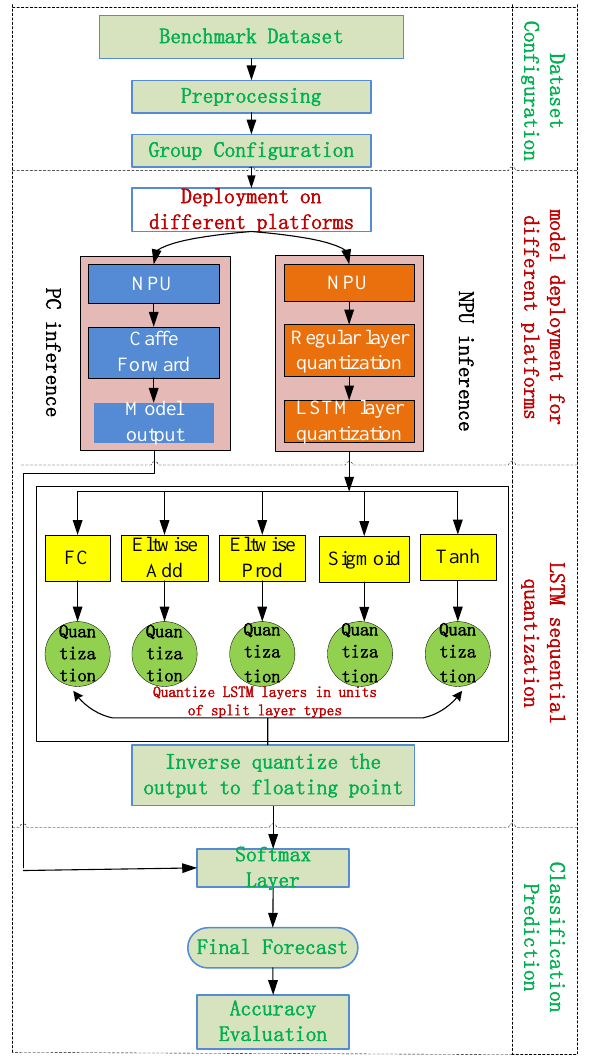
Figure 1. Overall method design process.